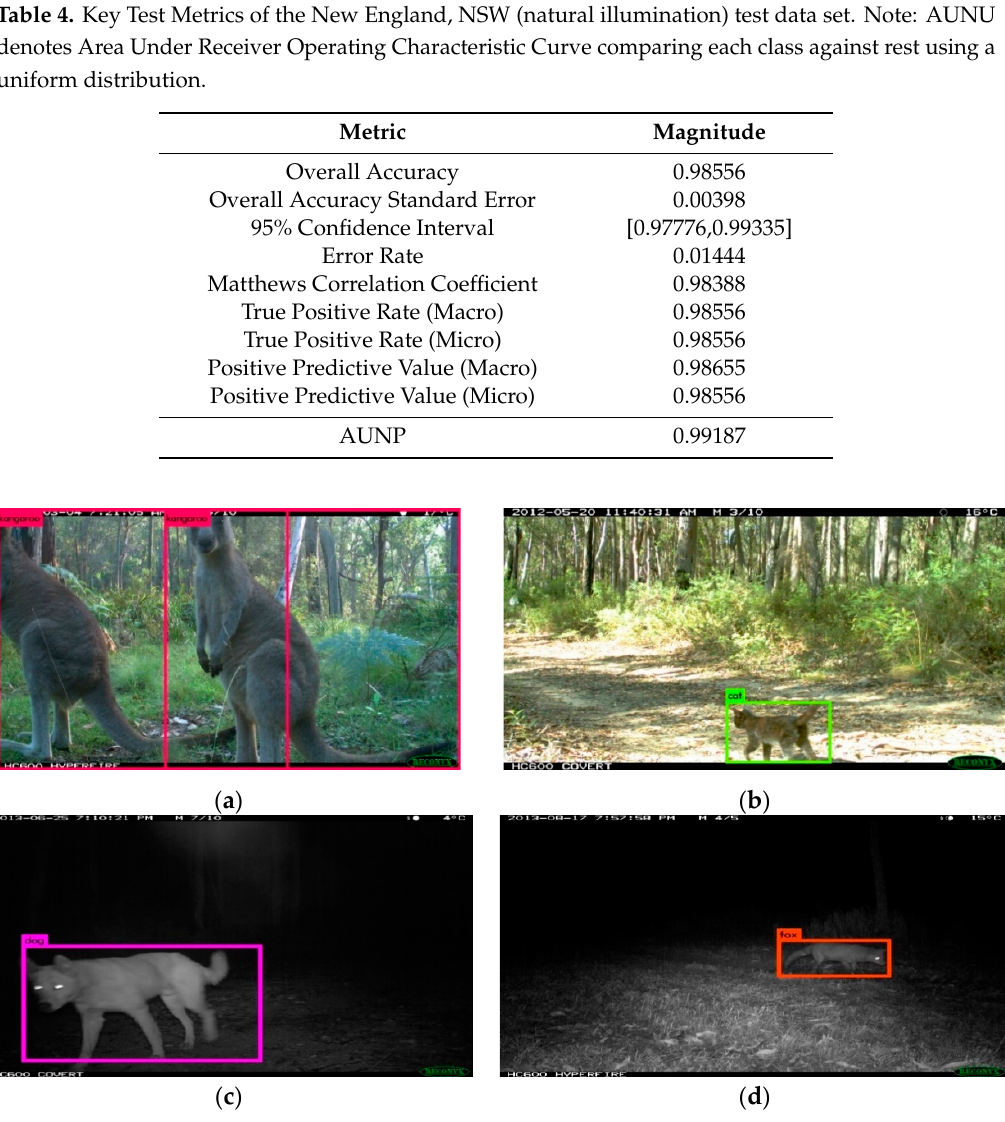
Figure 4. Detection Image examples from the New England dataset. ( a ) Macropod (Kangaroo), ( b ) Cat, ( c ) Dingo (dog) and ( d ) Fox.